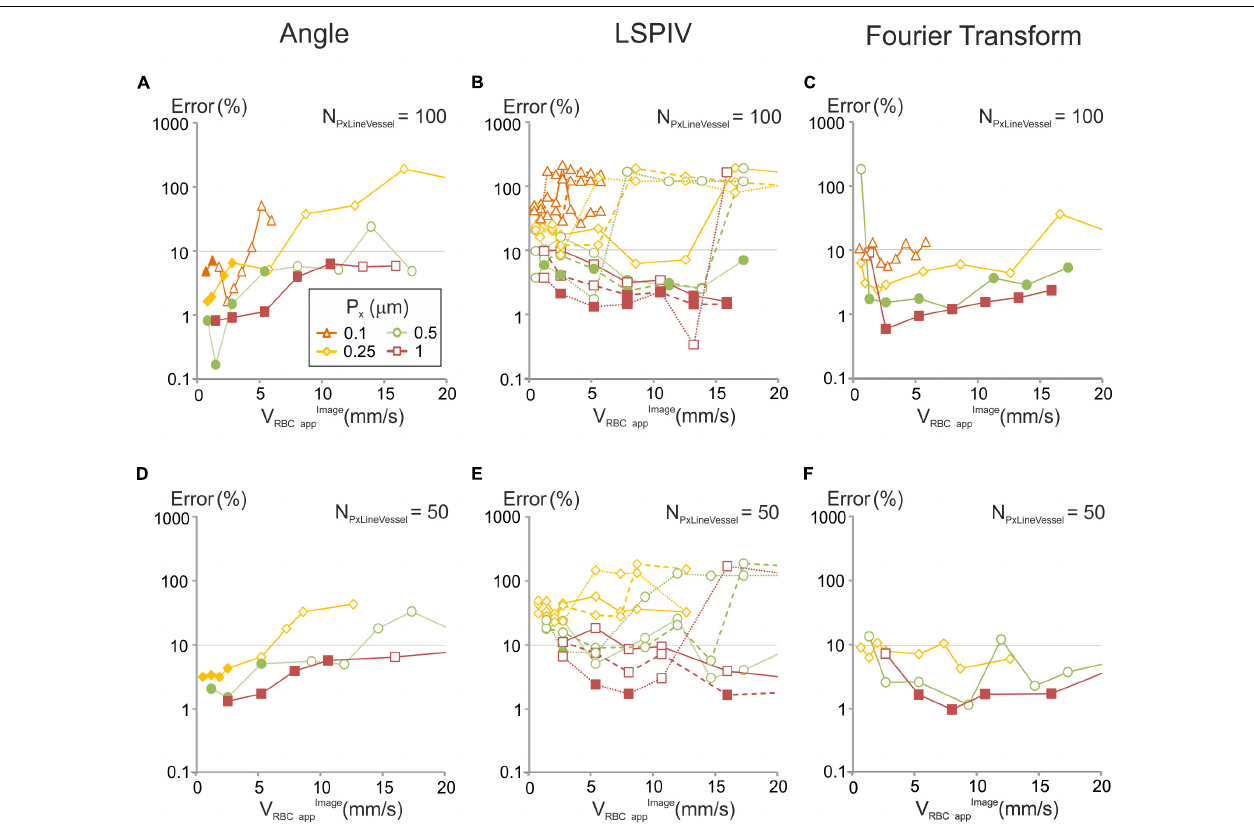
FIGURE 5 | Errors in velocities computed with each of the image-analysis algorithms for various of acquisition parameters and comparison with our models for a 10% error level. Artificial line-scans of constant velocity (V RBCappimage ) were processed with each algorithm: (A,D) angle; (B,E) LSPIV, full line (N Tline = 1), dashed lines (N Tline = 2) and dotted lines (N Tline = 5); (C,F) Fourier Transform, and the relative error was calculated (see methods) in two scanning conditions: (A–C) N PxLineVessel = 100, (D–F) N PxLineVessel = 50, with F p = 200 kHz. When the scanning conditions met the criteria in which our model predicts a signal over noise be-low 10%, a full symbol was used. In other conditions an empty symbol is